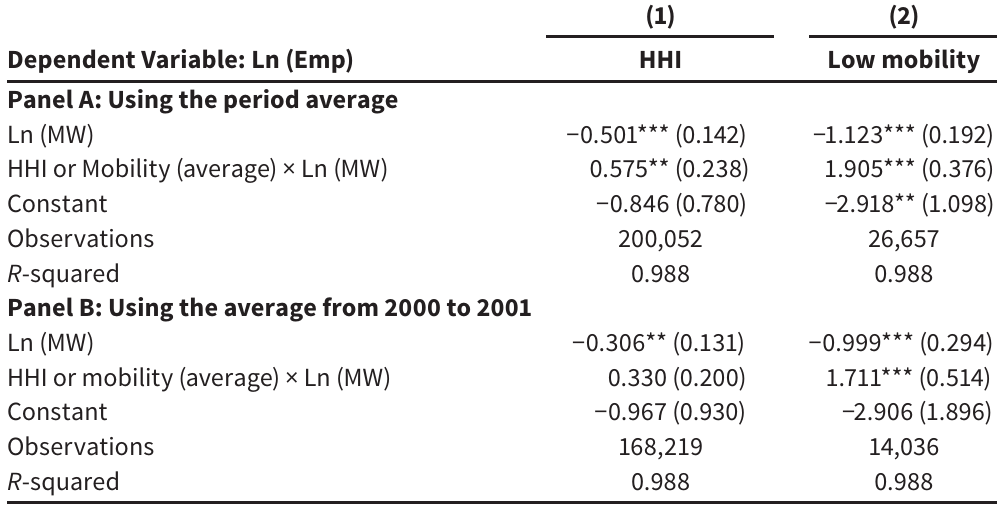
R -squared Robust clustered standard errors in parentheses by